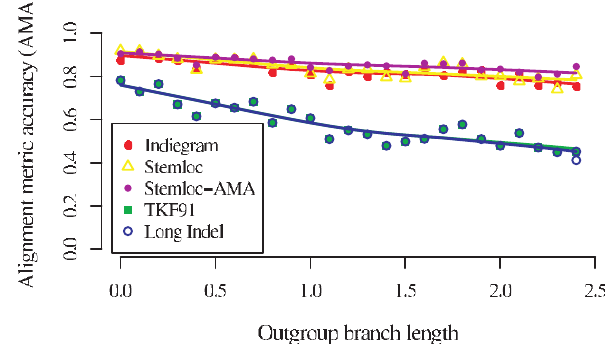
Figure 10. Dependence of perfect alignment rate on alignment method and outgroup branch length. Perfect alignment is when a given alignment program estimates the alignment 100% correctly, with no errors. Simulating the evolution of three structural RNAs under the TKFST model, we investigated the dependency of perfect alignment rate on outgroup branch length. The simulation included two sister species at unit distance from the ancestral sequence, plus one ‘‘outgroup’’ whose branch length t was varied between ½ 0,2 : 5 (cid:1) by selecting 25 equally spaced values of t in this range, spaced 0 : 1 apart. (A unit-length branch here corresponds to one expected substitution per site in loop sequence.) We simulated 25 alignments for each value of t , using TKFST model parameters described in the text. Since the perfect alignment rate is rather low, we further aggregated the t - values into bins of five; thus, for example, the bin named ‘‘ 0 to 0 : 4 ’’ includes t [ f 0,0 : 1,0 : 2,0 : 3,0 : 4 g and represents 25 | 5 ~ 125 trials in total. The perfect alignment rate was measured for various statistical alignment inference procedures. These procedures are described in the text, but may be summarized very briefly as ML under the true model (‘‘Indiegram’’); greedy approximate-ML progressive alignment by single-linkage clustering with pair SCFGs (‘‘Stemloc’’); sequence annealing, a form of posterior decoding to maximize a sum-over-pairs accuracy metric, using pair SCFGs to get the posterior probabilities (‘‘Stemloc-AMA’’); statistical alignment using the TKF91 model, i.e. linear gap-penalties (‘‘TKF91’’); and statistical alignment using a long-indel model, i.e. affine gap-penalties (‘‘Long Indel’’).